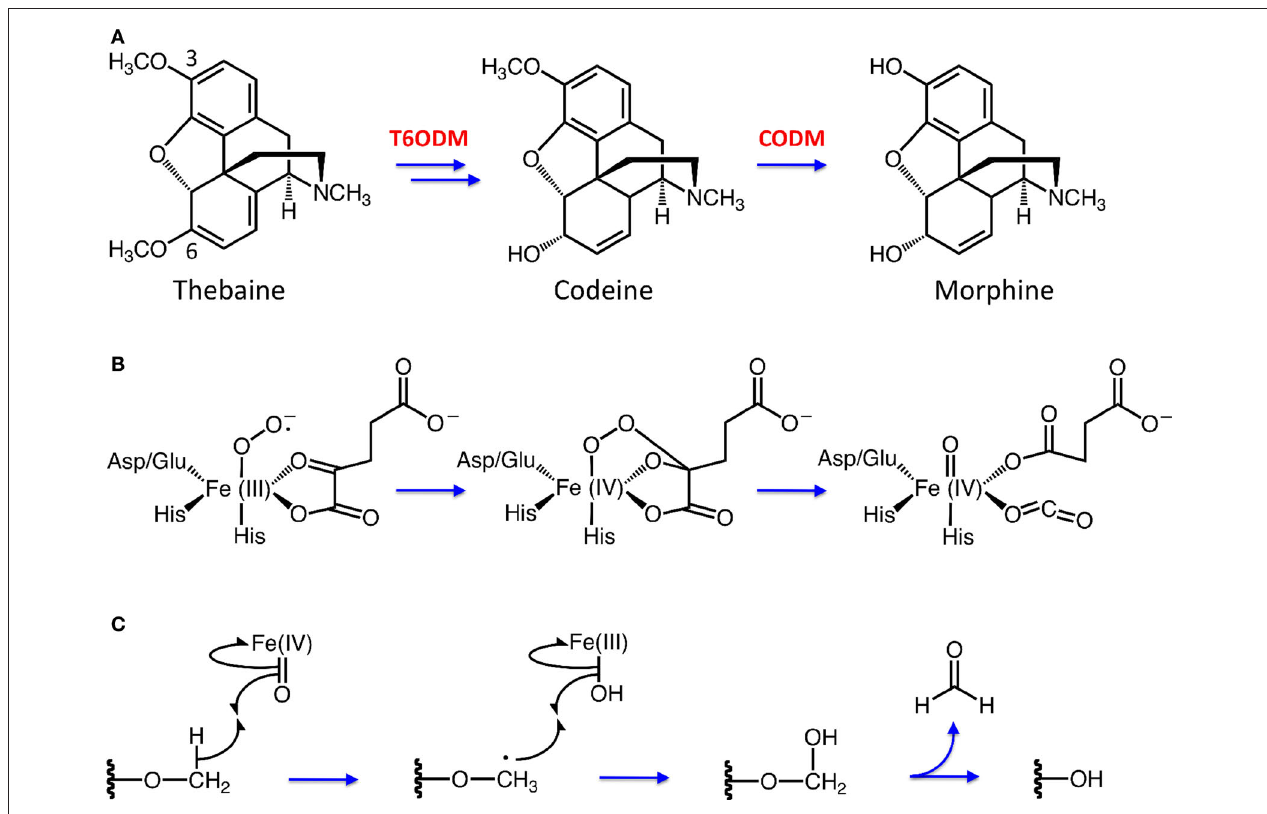
FIgure 1 | (A) Morphine biosynthesis in opium poppy requires two O -demethylation steps catalyzed by 2-oxoglutarate